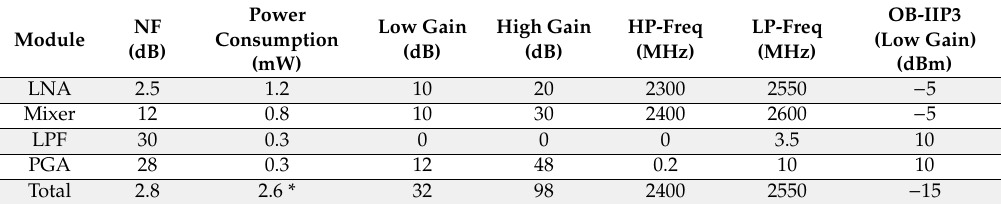
Table 1. Systematic design and simulation of the receiver